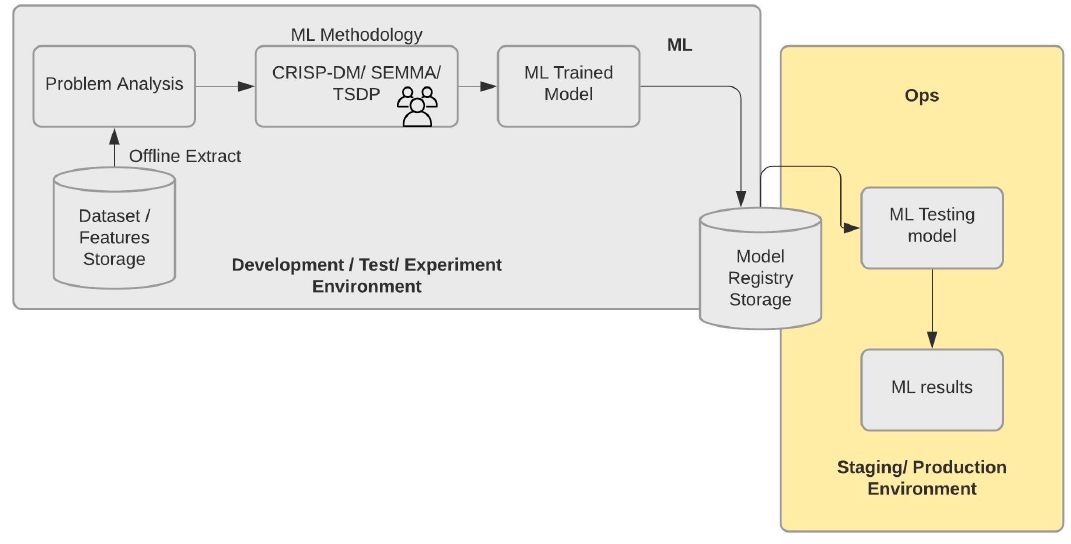
Figure 5. Machine learning manual pipeline process.